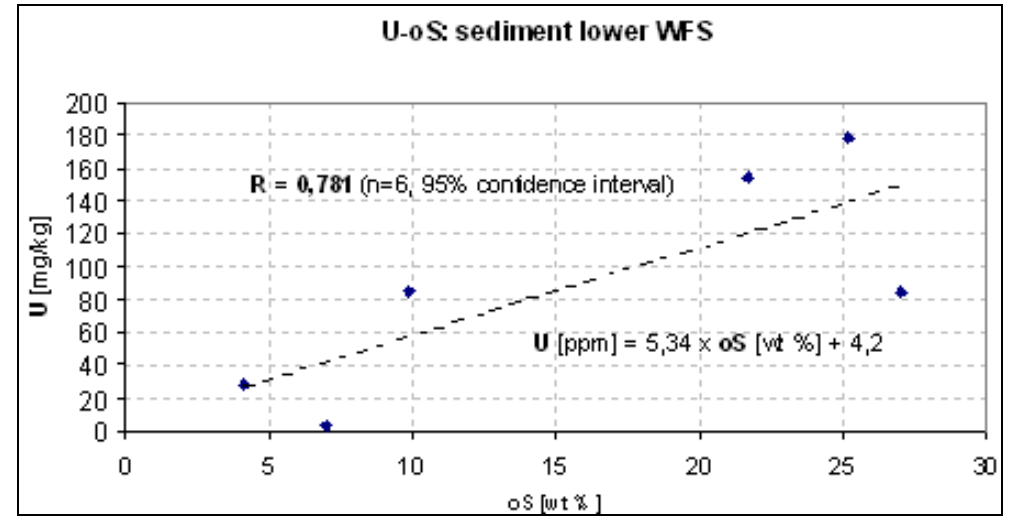
Figure 3. Relationship between the concentration of U and organic substance in sediments of the WFS stream bed (correlation coefficient, r 2 =